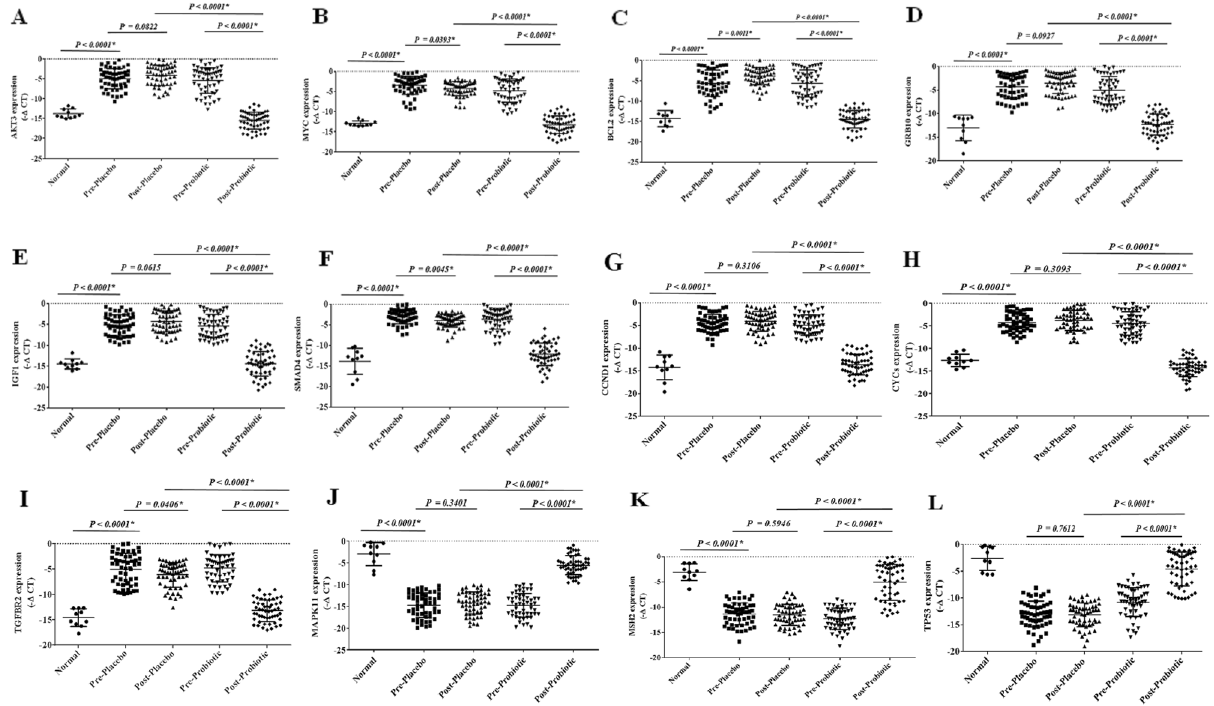
Figure 8 . The relative expression of the candidate genes in rectal cancer patients. The relative expression level of the genes was normalized by using a reference gene. The oncogenes included: ( A ) AKT3, ( B ) MYC, ( C )